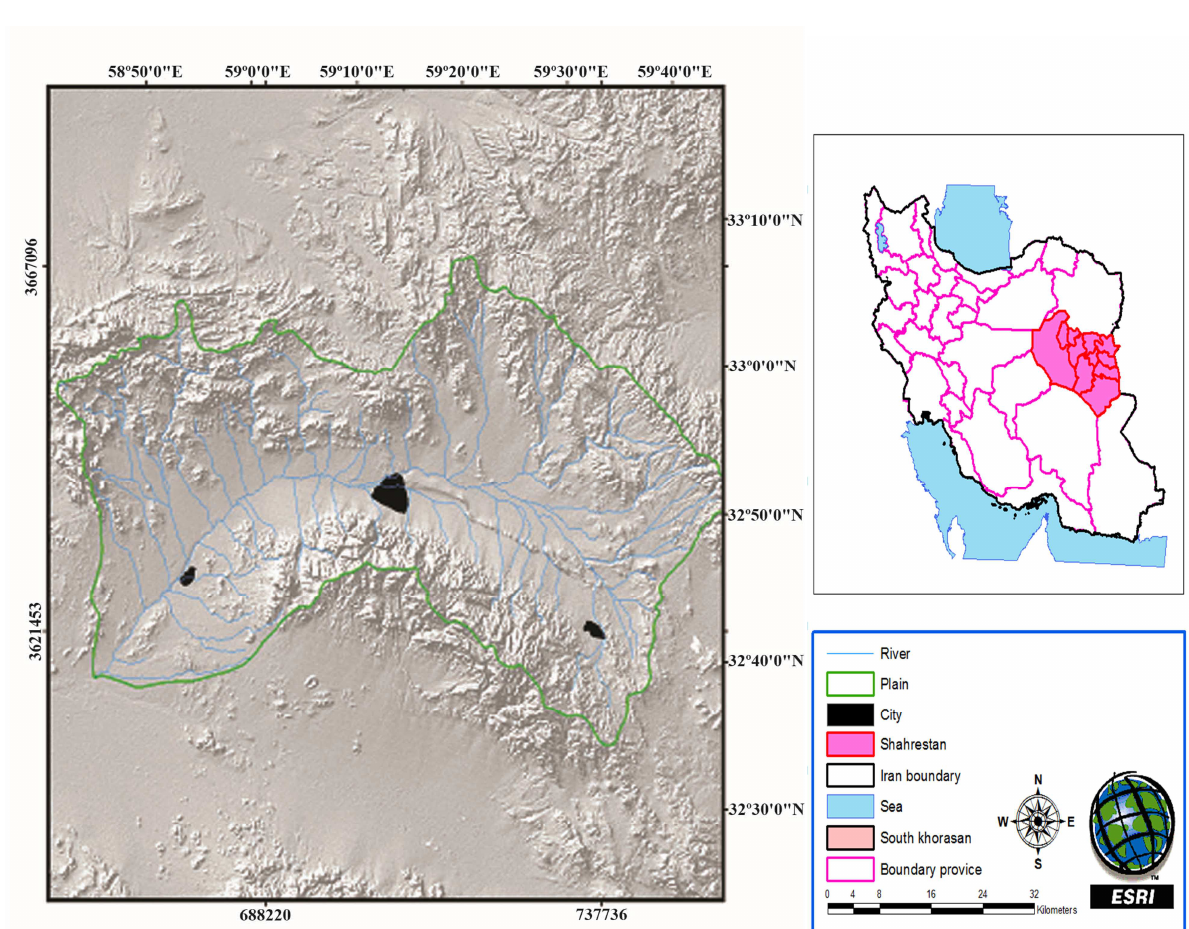
Figure 1. Map of the study area (Birjand, Iran flood plain) Table 1. Methods used for estimation of physicochemical